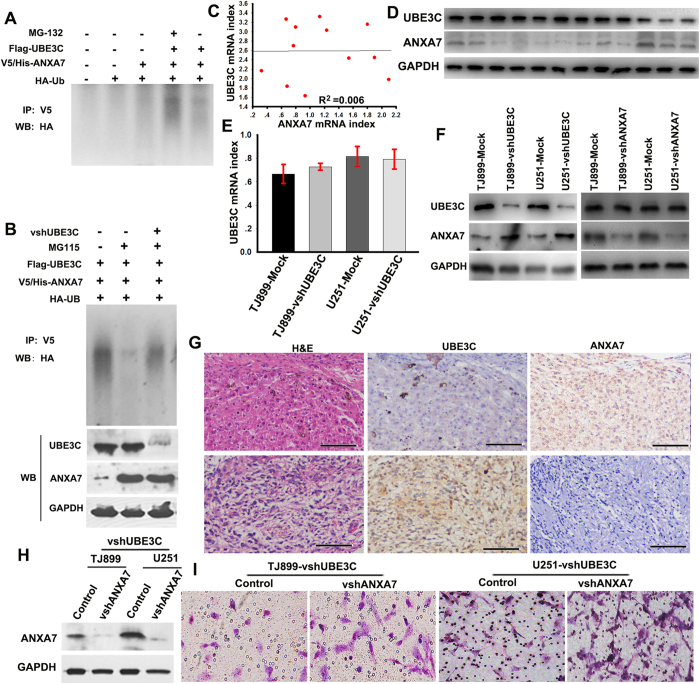
UBE3C promote gliomas progression by mediating ANXA7 degradation (A)The UBE3C on ANXA7 ubiquitylation in vivo. V5-ANXA7 and HA-Ub were co-transfected with Flag-UBE3C into 293T cells, and lysates of 293T cells were immunoprecipitated with the indicated antibodies and analyzed by immunoblotting using the anti-Flag, V5 and HA antibody, which detected poly-ubiquitylated ANXA7. (B) ANXA7 degradation is inhibited after UBE3C interference. (C) The correlation of UBE3C and ANXA7 mRNA in gliomas tissues; (D) The expression of UBE3C and ANXA7 proteins in gliomas tissues; (E and F) The forced loss of UBE3C up-regulated the ANXA7 protein, while not the ANXA7 mRNA; (G) Expression of UBE3C and ANXA7 protein was analyzed by IHC in gliomas tissues (bar = 200μm); (H) The expression of ANXA7 were regulated in TJ899 and U251-vshUBE3C cells by RNA interference; (I) Matrigel invasion assays showed that down-regulation of ANXA7 was accompanied by a descend invasion in TJ899 and U251-vshUBE3C cells (bar = 200μm).